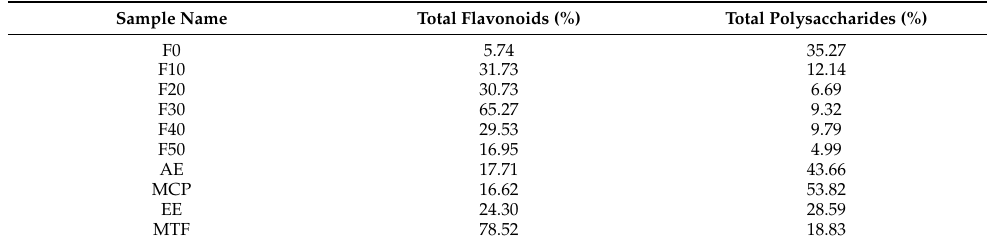
Table 1. Determination of total flavonoids and